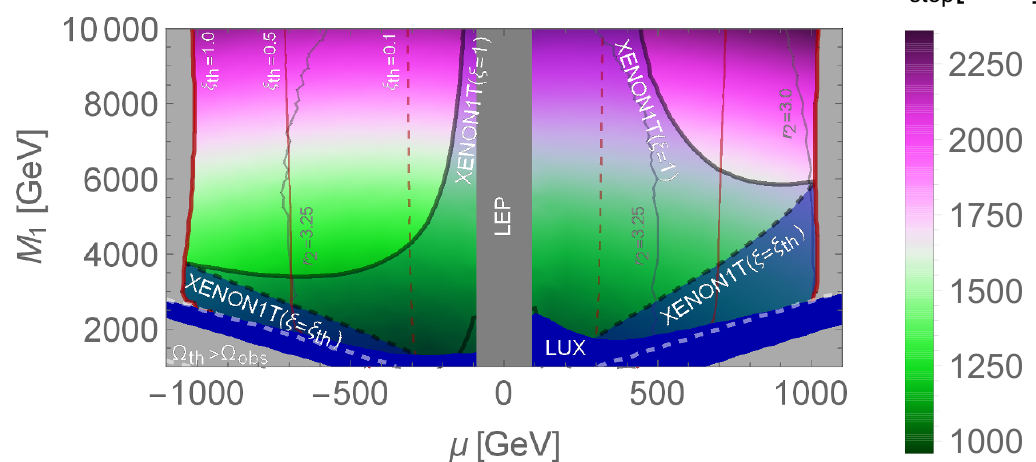
Figure 2 . Values of the dark matter observables with M 3 = 1 : 5 TeV. (cid:24) th (cid:17) (cid:10) th = (cid:10) obs = 1 is achieved in the red bands around j (cid:22) j = 1 TeV, and (cid:24) th = 0 : 5 (0 : 1) on the solid (dashed) red lines. (cid:10) th h 2 > (cid:10) obs h 2 in the light gray region. The LUX experiment excludes the blue bands if (cid:24) = 1 and region below the white dashed lines if (cid:24) = (cid:24) th . The region below the dark solid (dashed) blue lines where is the transparent blue region will be covered by the XENON1T experiment if (cid:24) = 1 ( (cid:24) th ). The gray lines show the wino-to-gluino mass ratio r 2 (cid:17) M 2 =M 3 at the uni(cid:12)cation scale. The gray region where j (cid:22) j < 90 GeV is excluded by the LEP